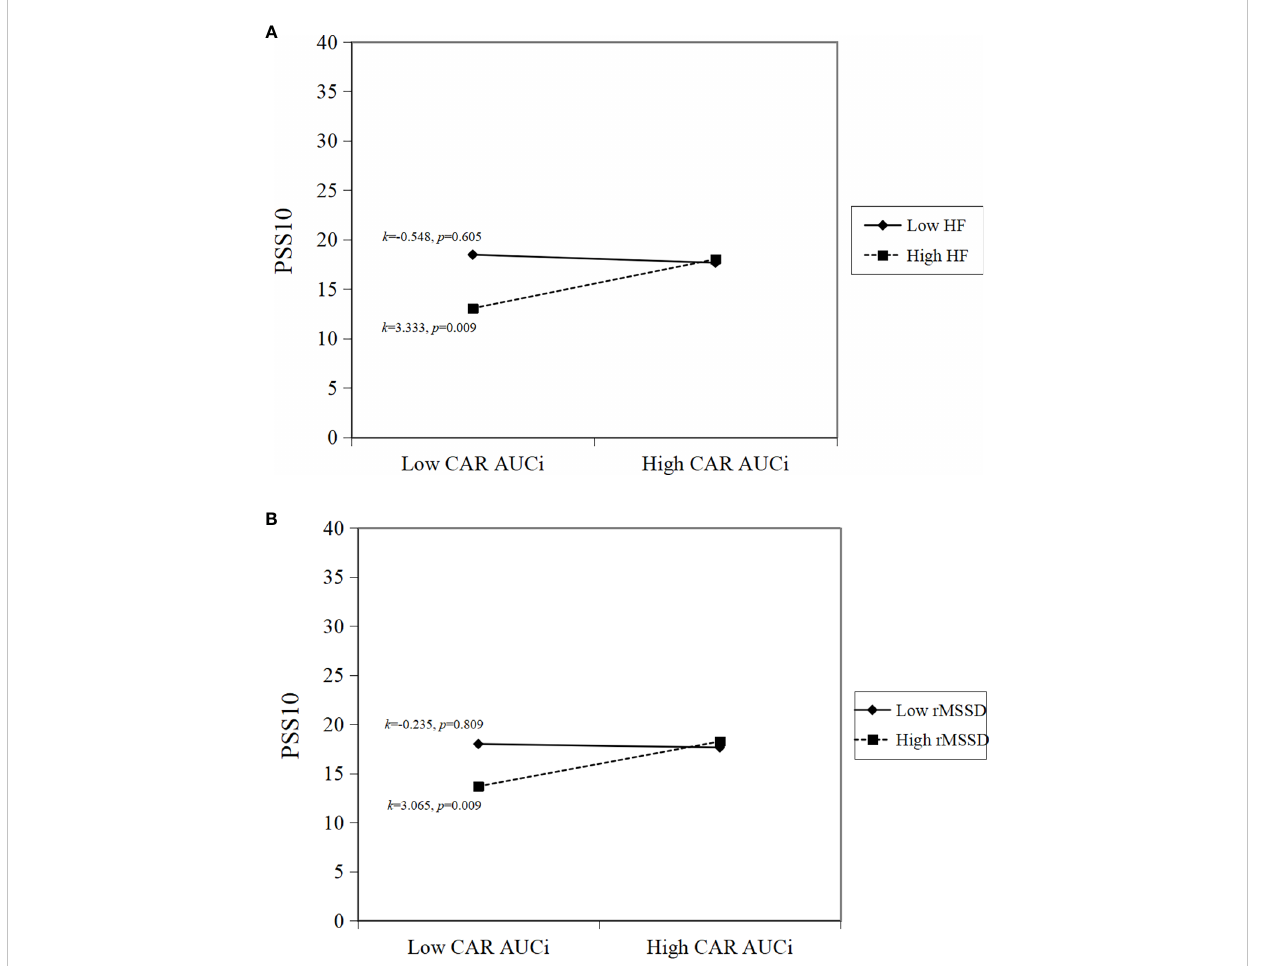
FIGURE 1 Simple slope interpretations of signi fi cant inter-relations. Higher sympathovagal modulation and higher cortisol awakening response are associated with greater perceived stress. In the panels, (A) higher HF and higher CAR AUCi; (B) higher rMSSD and higher CAR AUCi, are associated with higher perceived